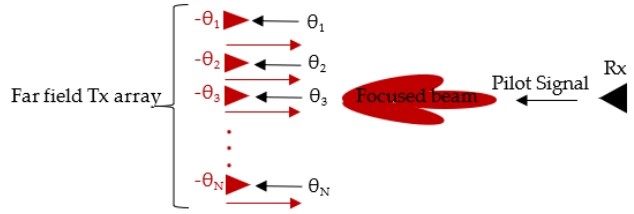
Figure 2. Retrodirective WPT approach.